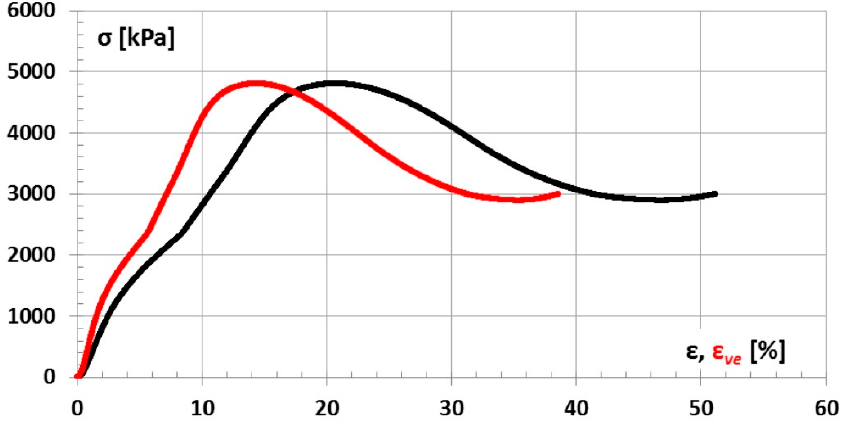
Figure 24. Stress σ relation to strain ε and ε ve graph.